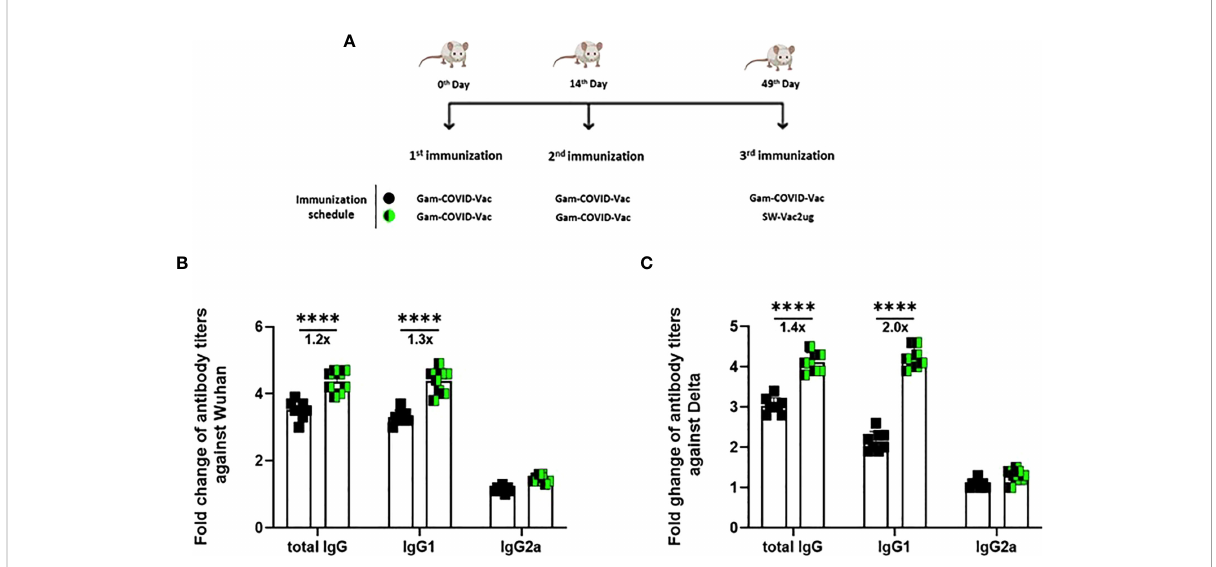
FIGURE 6 Anti-spike IgG titers induced by a booster with SW-Vac 2µg formulation or commercial vaccine in mice. BALB/c mice (n=8/group) were immunized on Days 0 and 14 with commercial Gam-COVID-Vac-rAd26/rAd5 vaccine plus a booster with SW-Vac formulation or Gam-COVID- Vac-rAd5 on Day 49 delivered intramuscularly (A) . Serum collected on Day 14 after the last dose was analyzed by ELISA to determine the levels of W (B) or (C) S-speci fi c IgG, IgG1 and IgG2a. Sera titers were obtained by plotting the OD 492 nm vs. log curve of the reciprocal of the dilution in the GraphPad Prism program. Titers are expressed as the inverse of the in fl ection point dilution of the curve. For statistical analysis, antibody titers were log-transformed and then analyzed by a one-way ANOVA with Bonferroni ’ s multiple comparisons test. For all treatments, the titers detected after the second dose were signi fi cantly different from those found after the fi rst dose (p<0.0001).